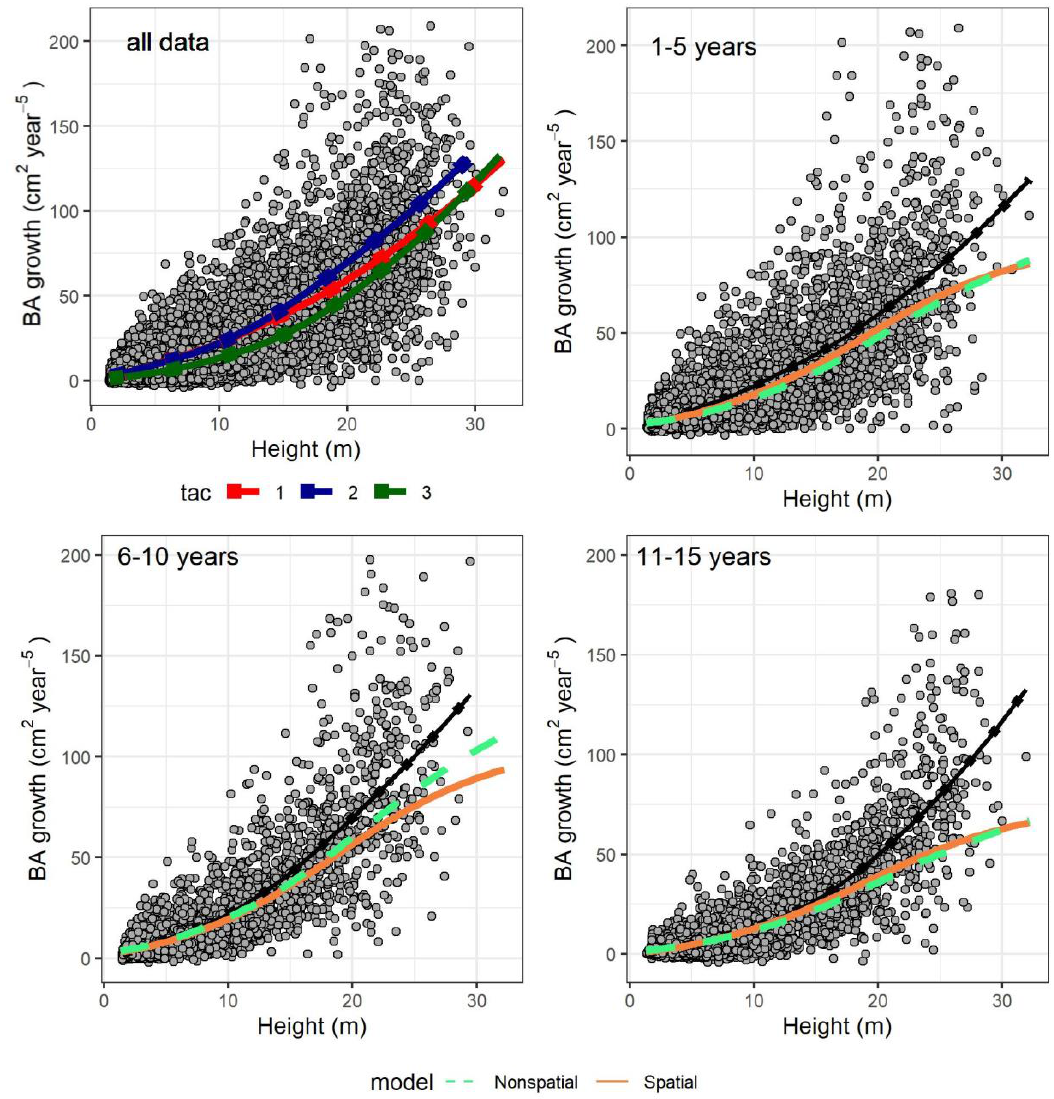
Figure 4. Individual basal area growth as function of tree height. The points are observed data (with continuous dotted lines as locally estimated scatterplot smoothing curves, or LOESS, estimated directly from the data, not from the models). Top left plot shows all data, and di ff erent observed LOESS curves for di ff erent time after harvesting classes ( tac1 ): 1–5 years, ( tac2 ): 6–10 years, ( tac3 ): 11–15 years. In the remaining graphs, only specific time after harvesting classes are displayed. The colored dashed and continuous lines are predicted values for the nonspatial and spatial model, respectively, while the black continuous dotted lines the corresponding LOESS curves of the top left